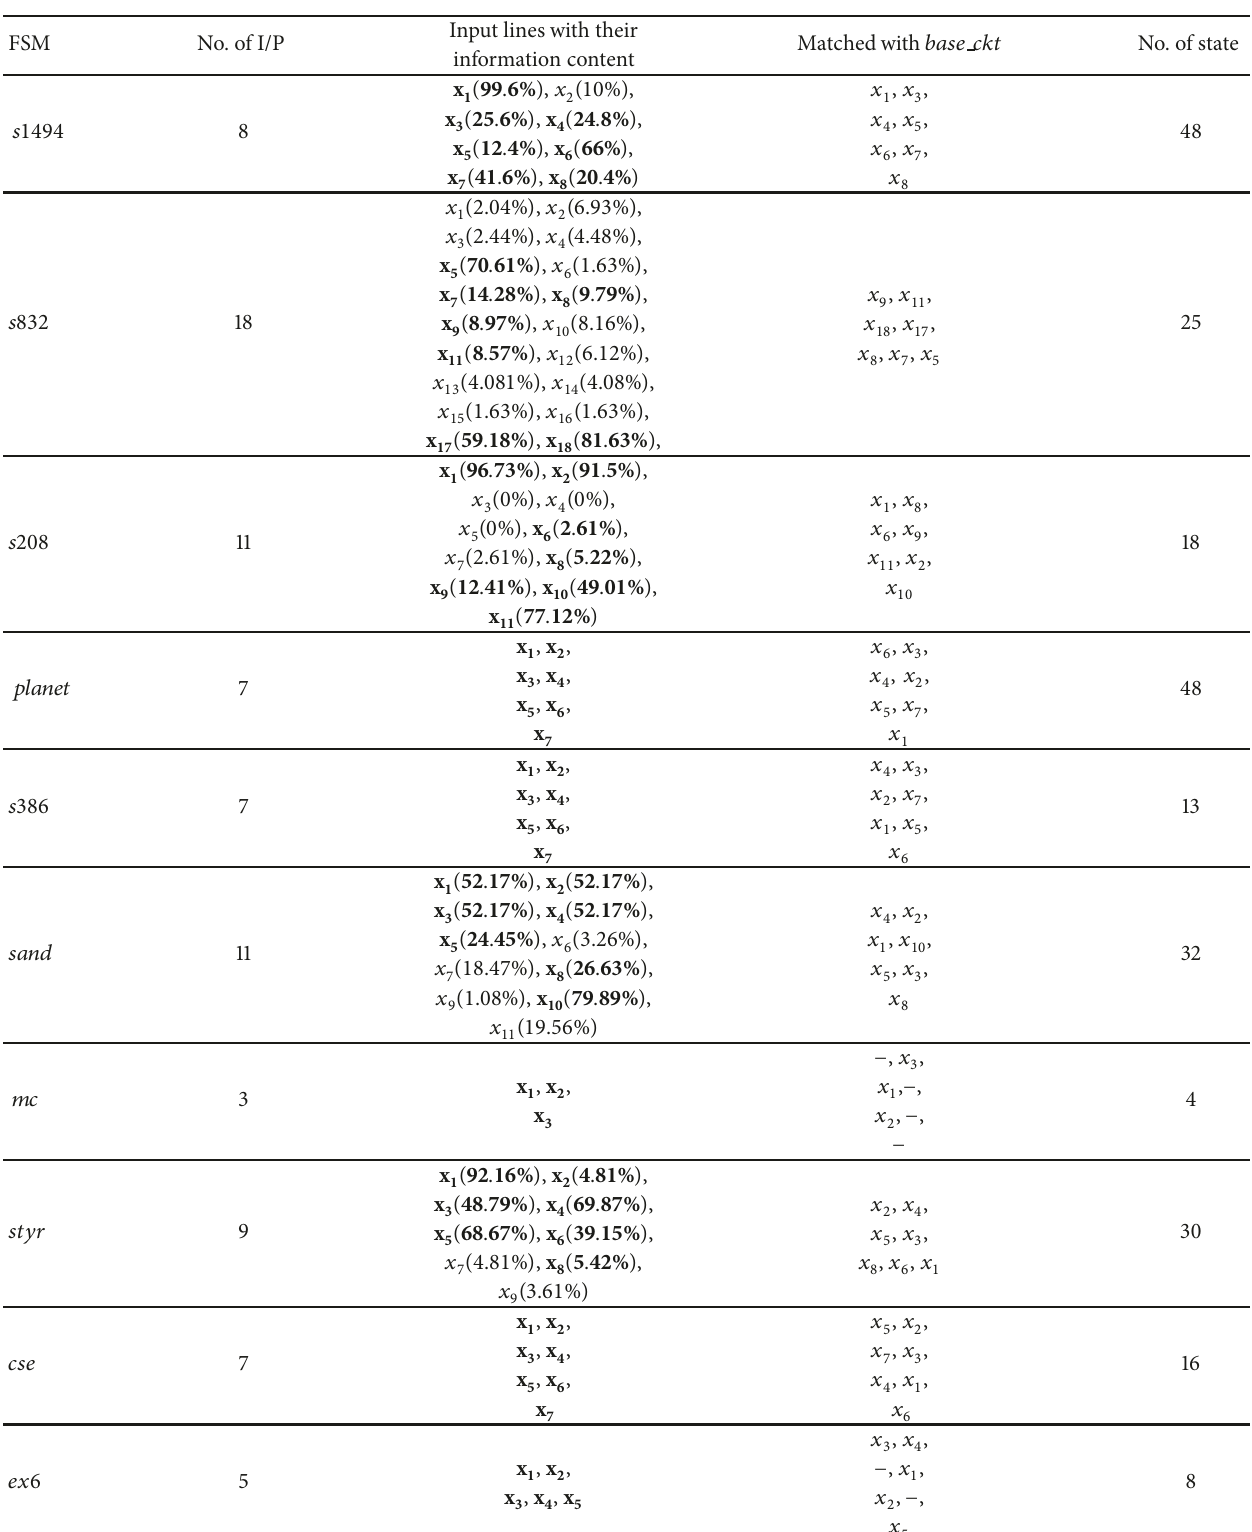
Table 5: The information content for input lines of MCNC FSM Benchmarks and their matching with input lines of 𝑏𝑎𝑠𝑒 𝑐𝑘𝑡 . FSM No. of I/P